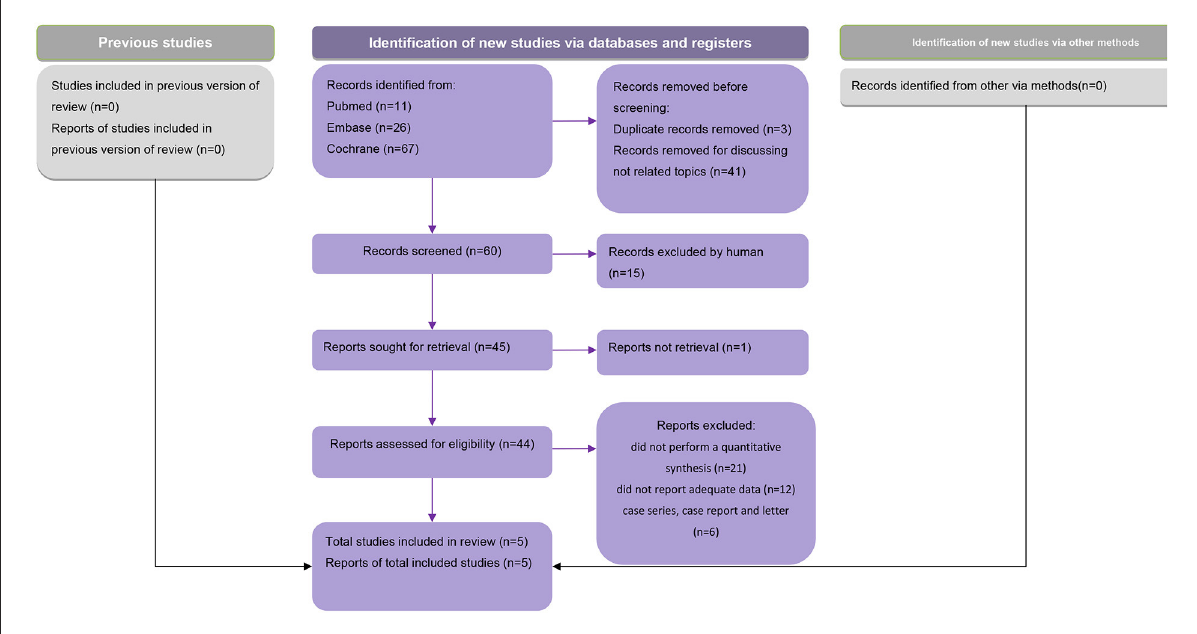
FIGURE1 PRISMA flow